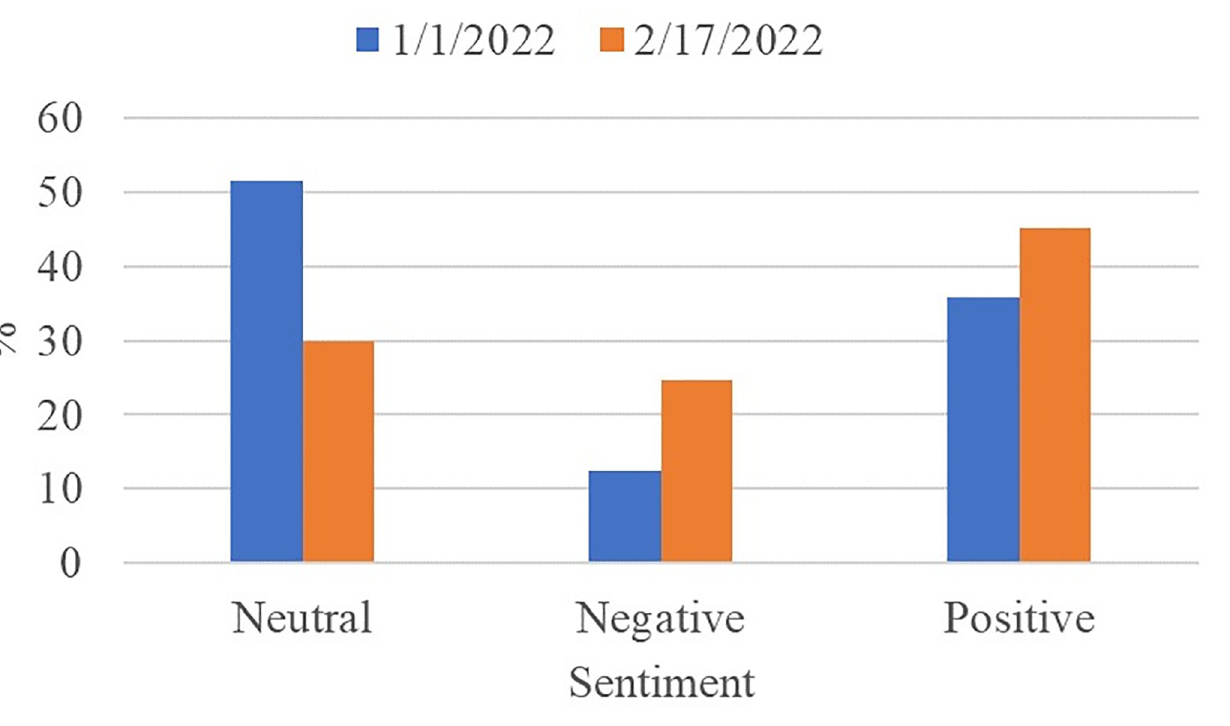
PLOS ONE | https://doi.org/10.1371/journal.pone.0272350 August 24,